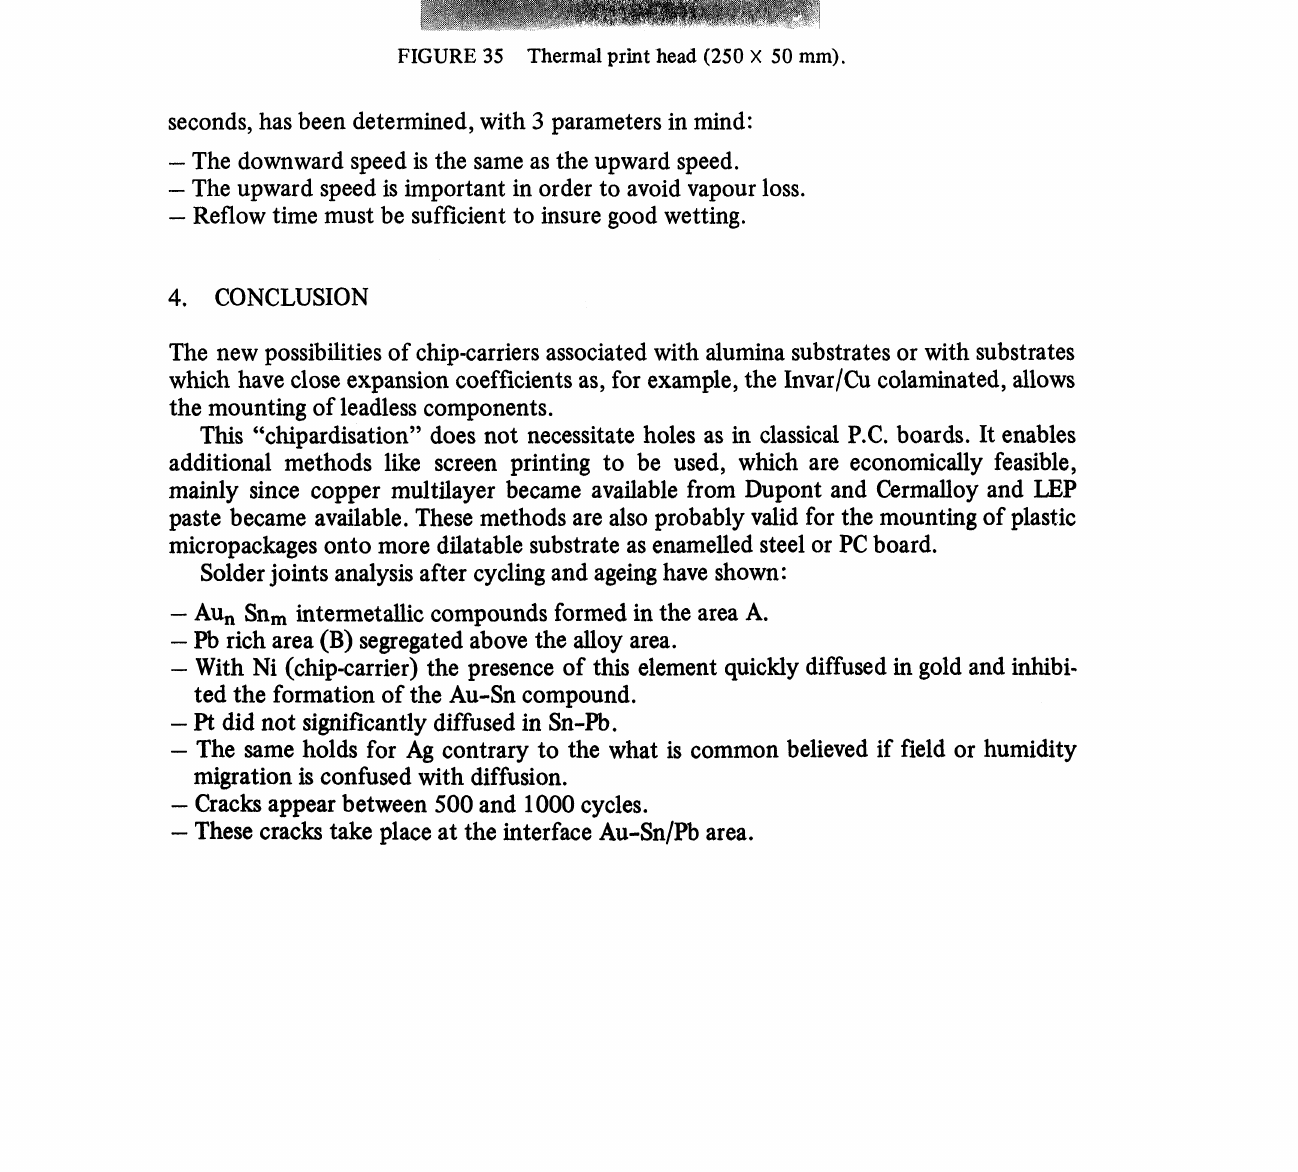
FIGURE 35 Thermal print head (250 50